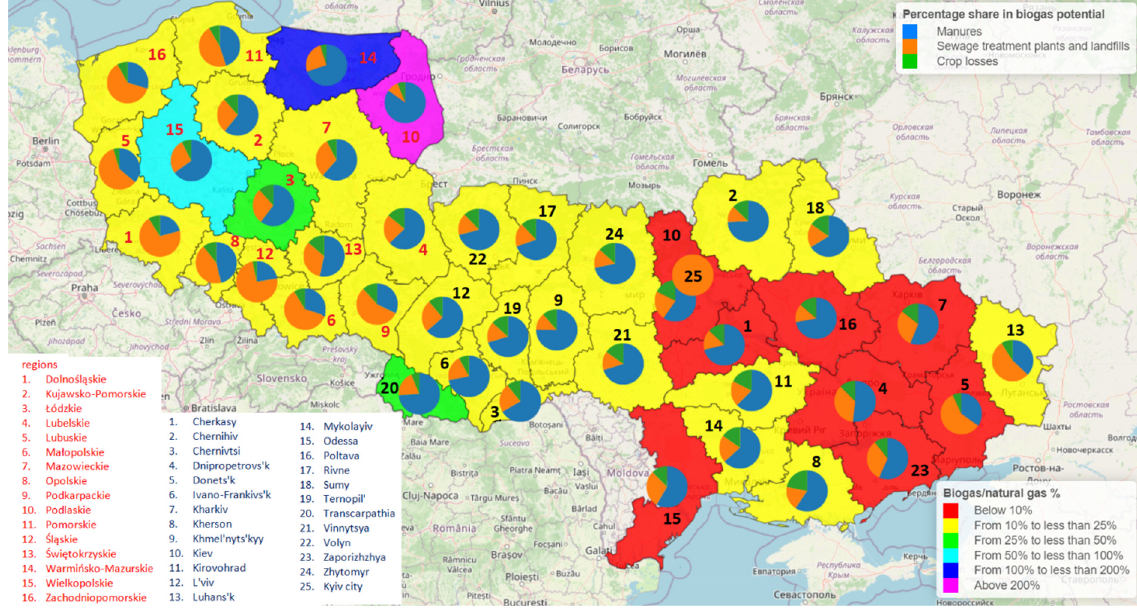
Figure 2. The basic potential of biogas production in relation to the consumption of natural gas with the share of individual sources. Source: Own study.